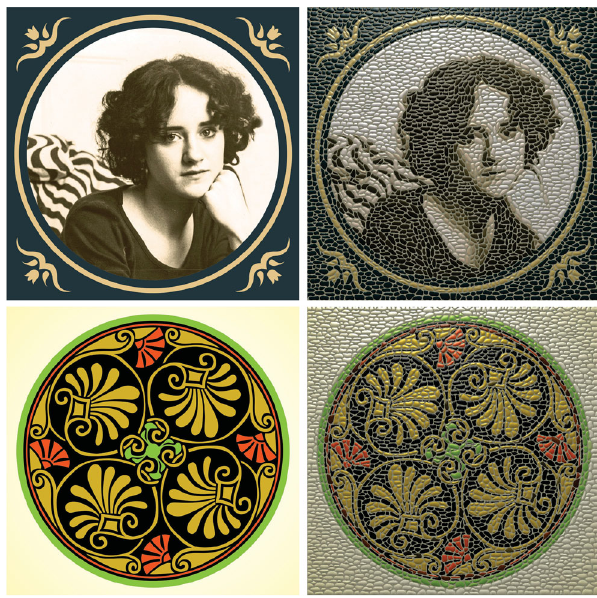
Fig. 11 Results for ornamental motifs. Left: input images. Right: results.